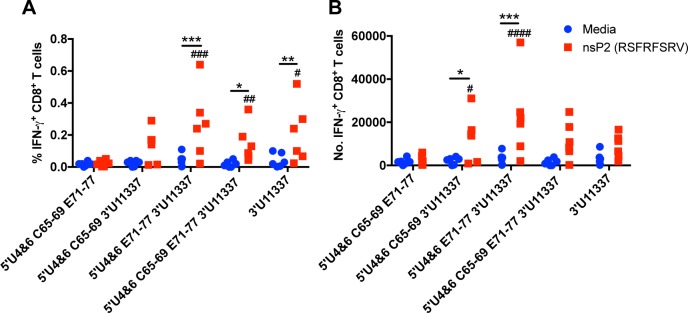
LAVs competent for myeloid cell replication induce early epitope-specific T cell responses in spleen.C57BL6 mice were immunized with equal genomes of the LAVs in both rear footpads. On day 6, splenocytes were stimulated with an EEEV-specific nsP2 peptide (1μM) for 5 hr. A) Percent of IFN-γ+ CD8+ T cells in spleen. B) Number of IFN-γ+ CD8+ T cells in spleen. *p<0.5, **p<0.01, ***p<0.001 by two-way analysis of variance with multiple comparisons using the Bonferroni method comparing between media and nsP2 stimulation of each LAV immunization. #p<0.05, ##p<0.01, ###p<0.001, ####p<0.0001 by two-way analysis of variance with multiple comparisons using the Bonferroni method comparing nsP2 peptide stimulation of each LAV with 5’U4&6 C65-69 E71-77n = 6 mice, 2 independent experiments.